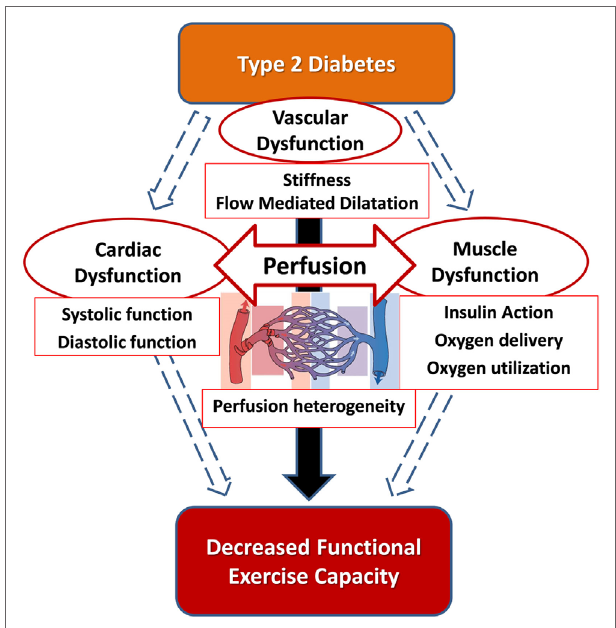
FiGURe 2 | The hypothesis that the integration of cardiac function, macrovascular function, and microvascular function is impaired in type 2 diabetes and correlates with cardiorespiratory fitness